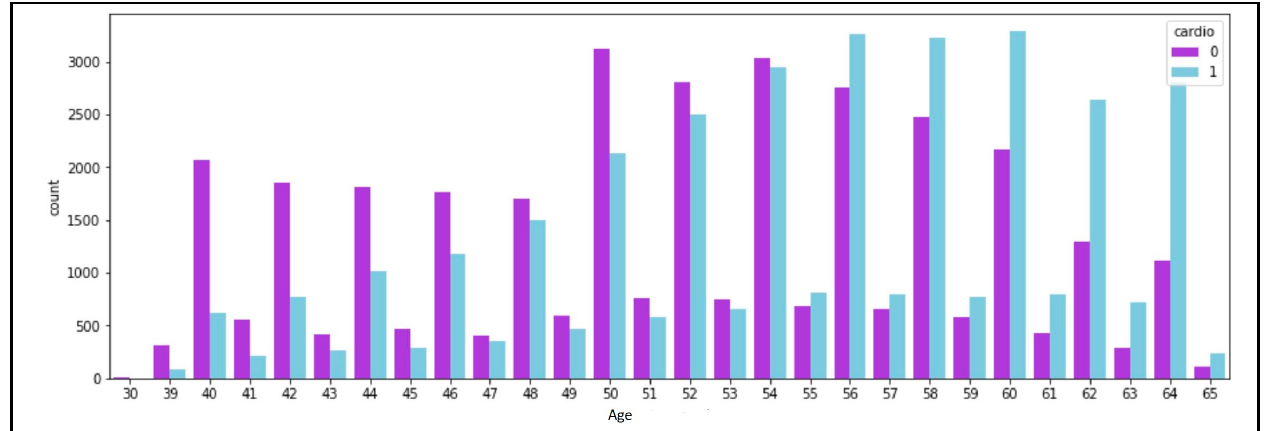
Figure 10. The graph above demonstrates that adults between the ages of 56 and 60 seem to be more susceptible to cardiovascular disease.